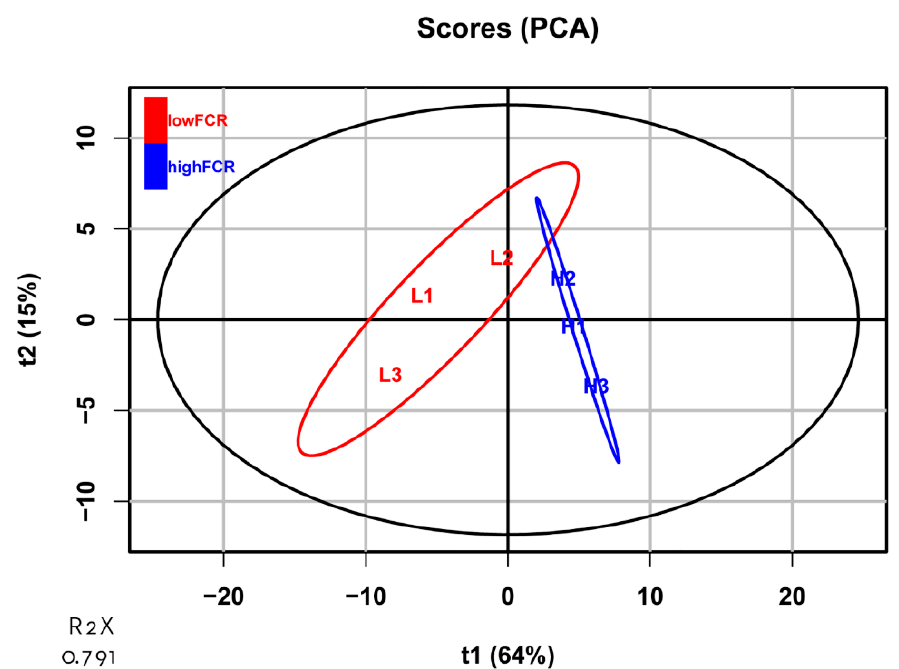
Figure 5. Principal component analysis (PCA) plot of all genes associated with FCR. The ellipses represent 95% confidence intervals for each group (high-FCR, blue; low-FCR, red). The abscissa and ordinate each represent a principal component, and the percentage represents the amount of variation between samples. R2X represents the accumulated variance contribution rate.